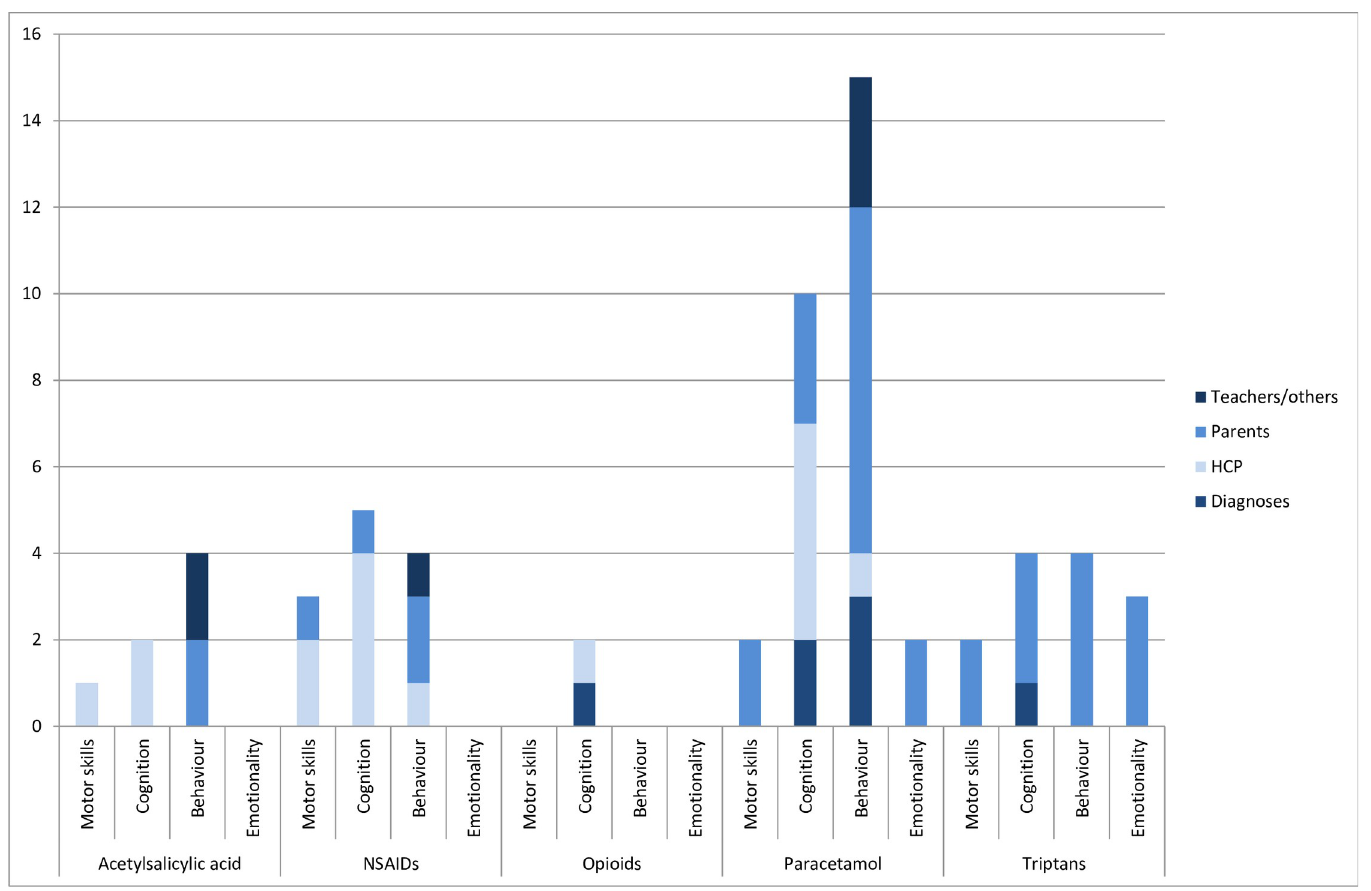
Fig 3. Domains of neurodevelopment evaluated and data sources used in medication safety papers on analgesics. Some papers had outcomes from more than one domain and assessments from more than one type of assessor. HCP: Health care professionals.